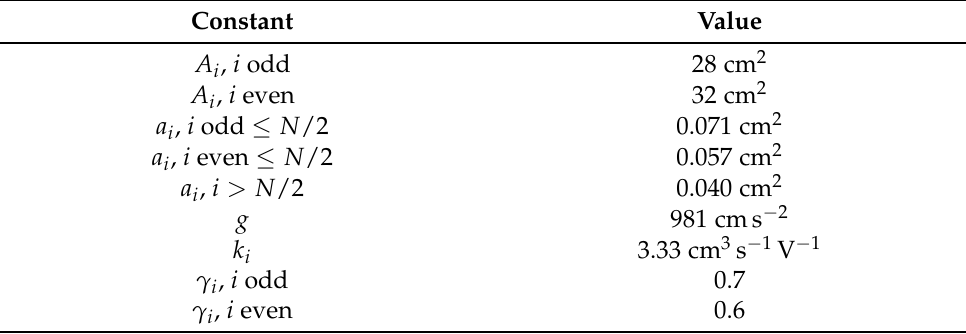
Table 1. Values of the physical constants of the N tanks